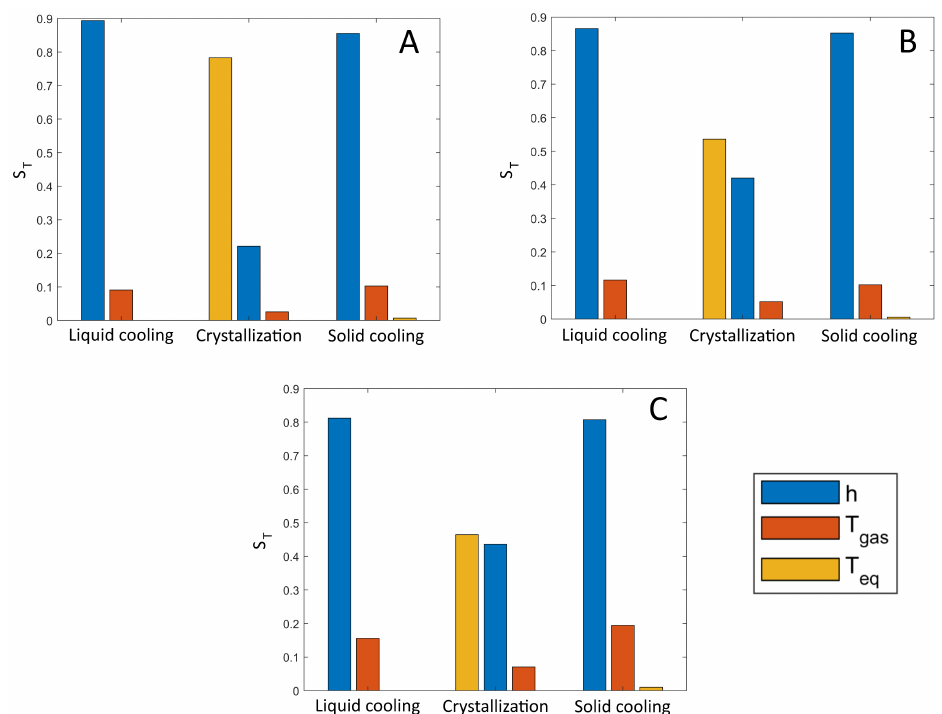
Figure 8. Global sensitivity analysis of the mechanistic model. Total order effect values S t are shown for every input parameter of the model during solid cooling, crystallization, and liquid cooling at different gas flow rates. Parameters with scores under 0.05 for every gas flow rate and phase of spin freezing are not shown. A: 20 L/min, B: 50 L/min, and C: 80